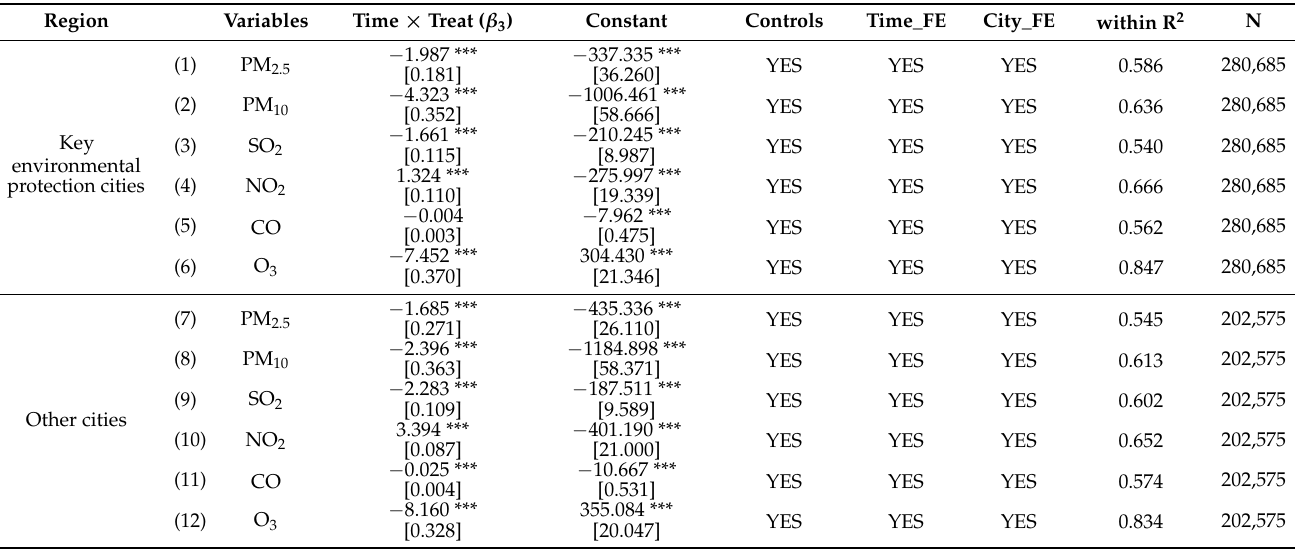
Table 4. Estimation results of the BSDW policy on air pollution in the environmental protection cities and other cities. Region